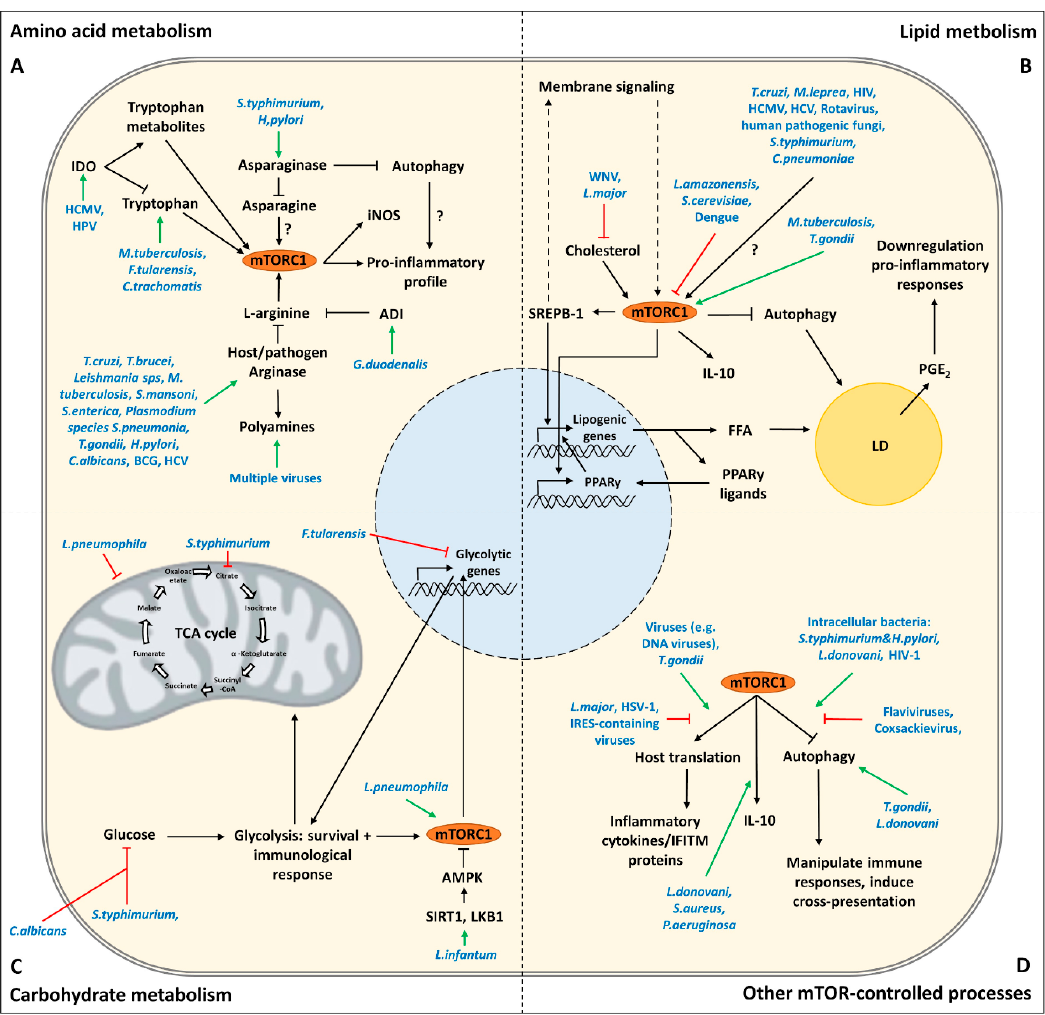
Figure 2. Overview of metabolic targets through which pathogens are known to modulate DC and macrophage functions. In ( A – D ), the key strategies through which different pathogens modulate ( A ) amino acid metabolism, ( B ) lipid metabolism, ( C ) carbohydrate metabolism and ( D ) other mTOR-controlled processes in DCs and macrophages to promote immune evasion are indicated Blue = pathogens involved; Red = inhibition by pathogens; Green = stimulation by pathogens.